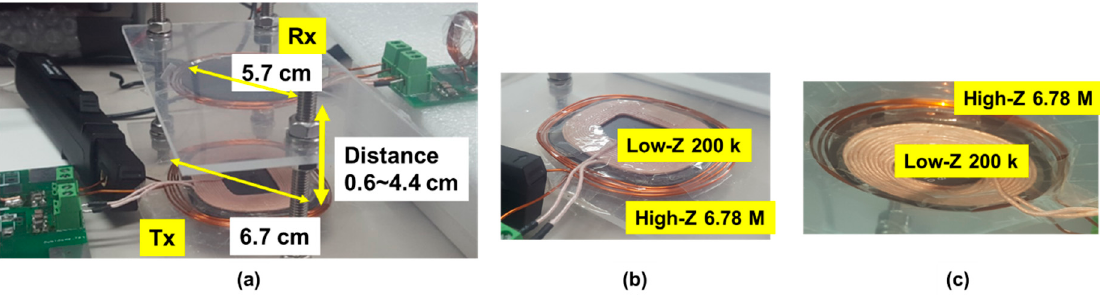
Figure 4. ( a ) Measurement setup. ( b ) Tx coils. Low-Z coils are within the high-Z coil. High-Z coil is wound around low-Z coil ( c ) Rx coils have similar configurations.